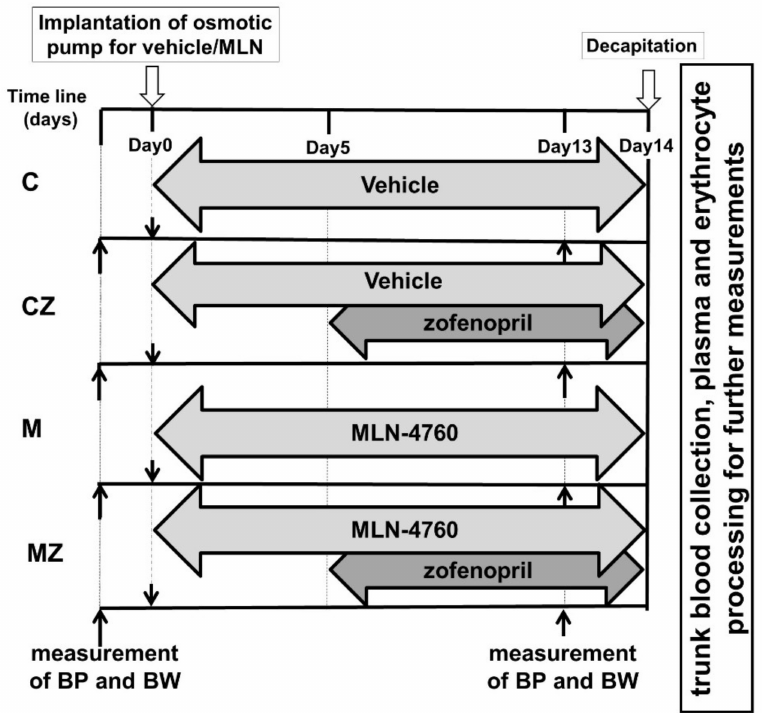
Figure 1. Experimental design. Abbreviations: C—control group, CZ—zofenopril-treated group, M—MLN-treated (MLN-4760, ACE2 inhibitor) group, MZ—zofenopril and MLN-treated group, BP—blood pressure, BW—body